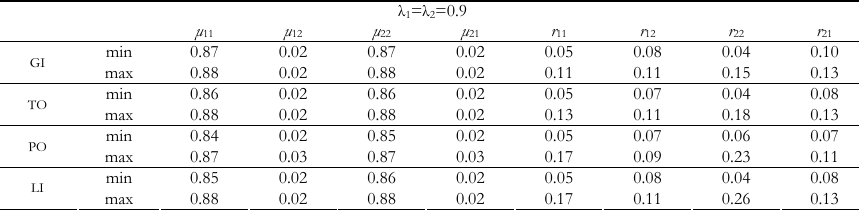
MGM results for the data set with λ 1 = λ 2 = 0.9: min and max of the mean correlations µ it with the associated ranges r it , i= 1,2 ; t= 1 , 2 , of the m i variables with the subscale to which they are ( i=t ) or are not ( i ≠ t ) a priori assigned to, with reference to the four scoring methods GI ( Gifi ) , TO ( Torgerson ) , PO ( Portoso ) and LI ( linear assignment